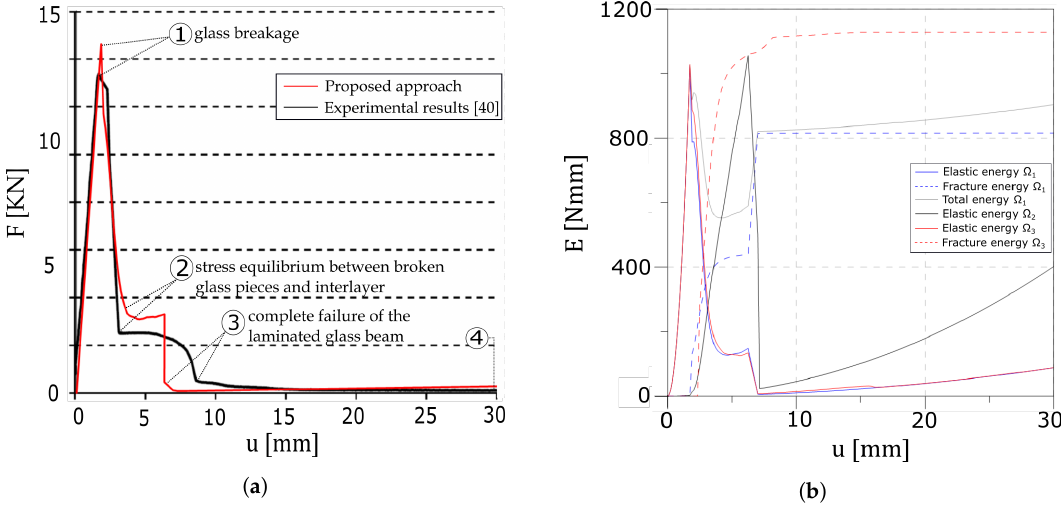
Figure 14. Numerical results of the four point bending test. ( a ) Force–displacement diagram of the proposed approach and experimental result taken from Figure 9 of the work in [40]. ( b ) Global evolution of the energy